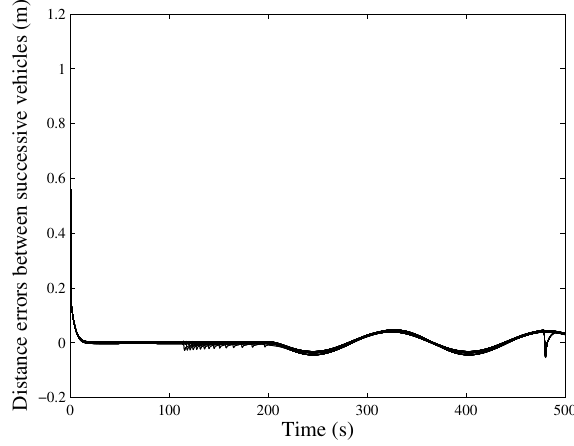
Figure 12. Graphs of the 100-set simulation distance